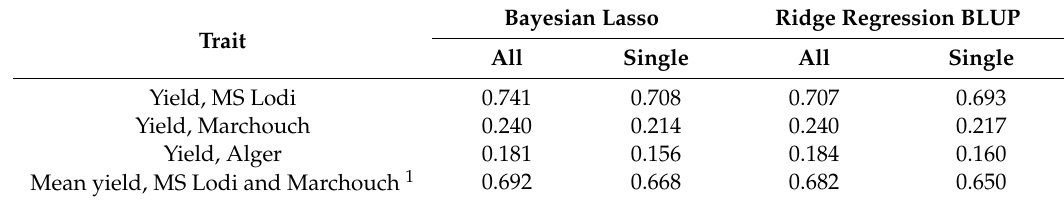
Averaged across results for three RIL populations encompassing 288 lines overall, considering models with five possible thresholds of genotype SNP missing data (10%, 20%, 30%, 40%, 50%). Fifty repetitions of 10-fold stratified cross-validations per analysis. 1 Using phenotypic data averaged across the two